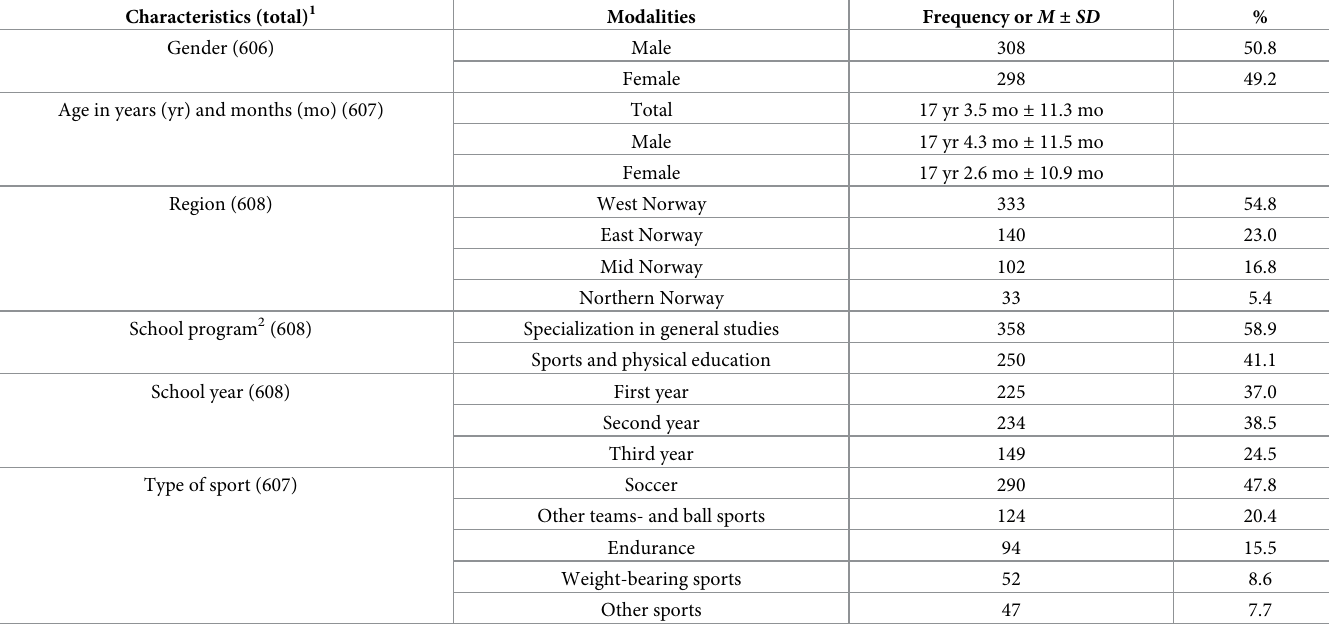
Table 1. Descriptive characteristics of the 608 student athletes in the present